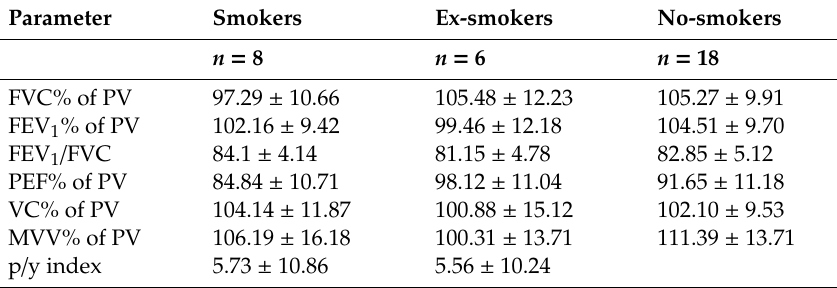
Table 5. Pulmonary function test (median ± SD) in the studied group a ff ected by smoking habits.